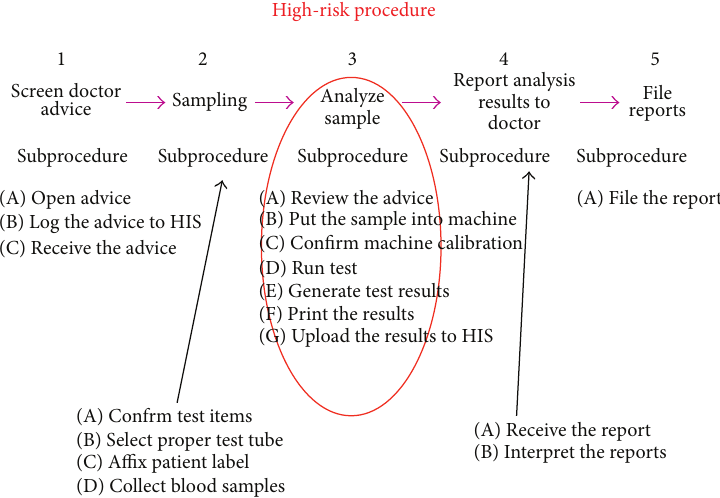
Figure 5: The test procedure for Down syndrome.